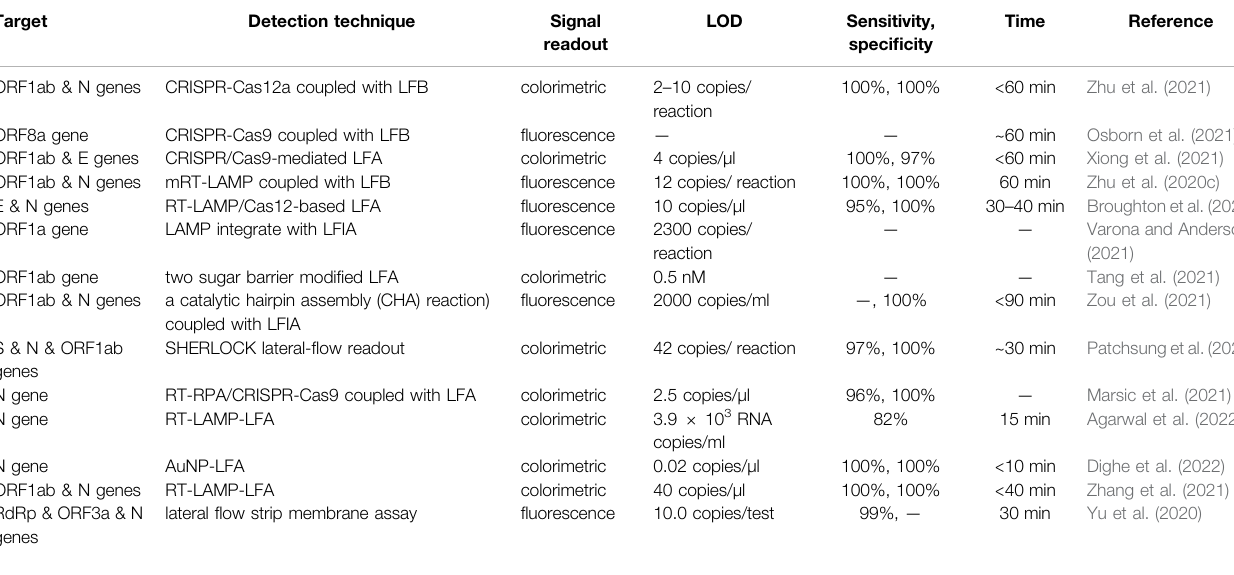
TABLE 1 | Nucleic acid ampli fi cation technique combined with the lateral fl ow assay for detection of SARS-CoV-2.